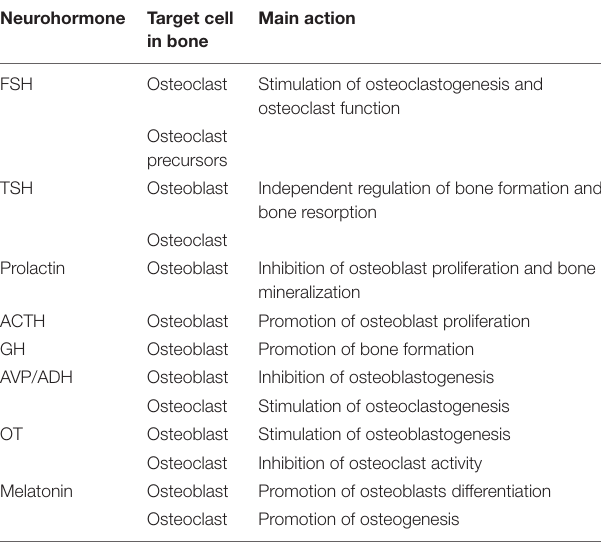
FSH, follicle-stimulating hormone; TSH, thyroid-stimulating hormone; ACTH, adrenocorticotropic hormone; GH, growth hormone; AVP/ADH, arginine- vasopressin/antidiuretic hormone; OT,